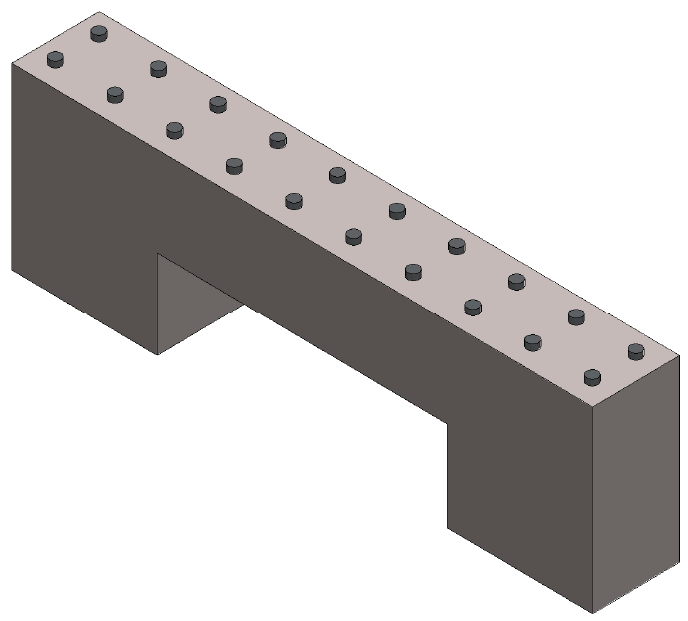
Figure 4. CAD design of the micro beam. The structures at the top of the design were designed as support.